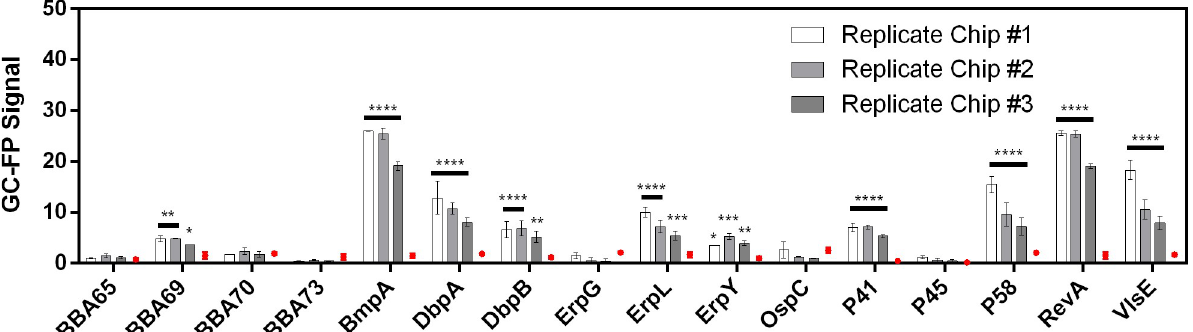
Fig 4. Inter-chip variation in GC-FP signal. The mean GC-FP signals ± Standard Error of the Mean is shown for three replicate biochips. The corresponding signals from a biochip processed with negative control serum is also shown (red dot). Black bars indicate where replicate biochips demonstrated significant difference from the negative control, and asterisks indicates a GC-FP signal significantly different from the negative control ( ���� , p < 0.0001; ��� , p < 0.001; �� , p < 0.01; � , p < 0.05; 2-way ANOVA followed by Fisher’s LSD test for multiple comparisons).